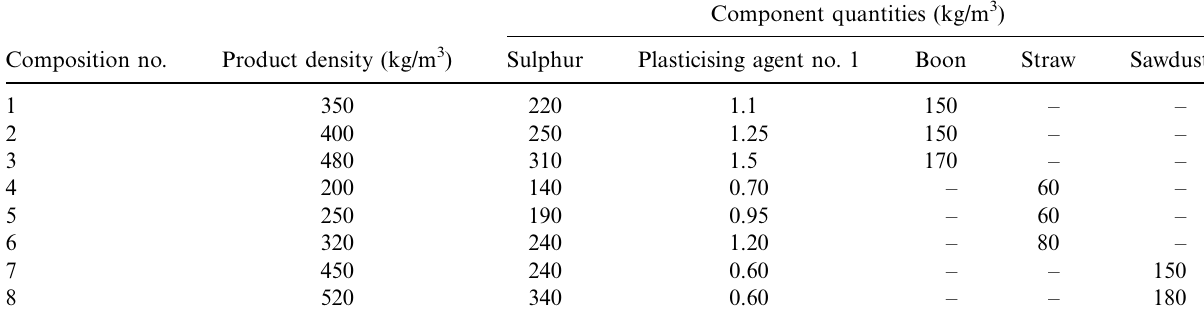
Component quantities (kg/m 3 )